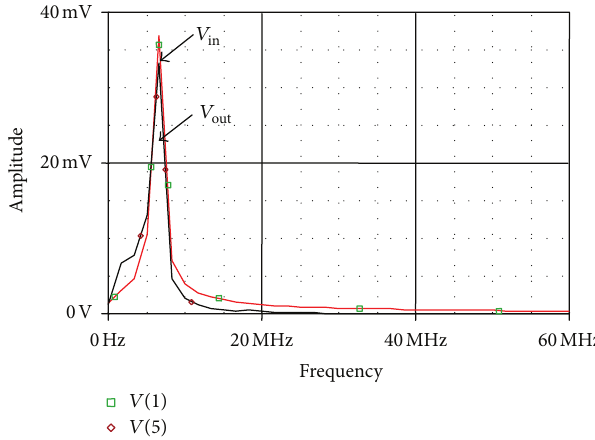
Figure 7: Fourier spectrum of input and output at 6 MHz.